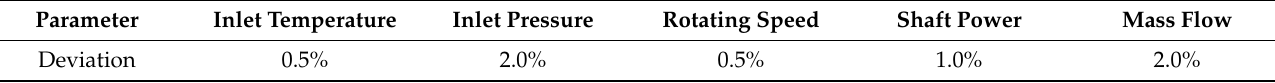
Table 4. Permissible fluctuations of experimental